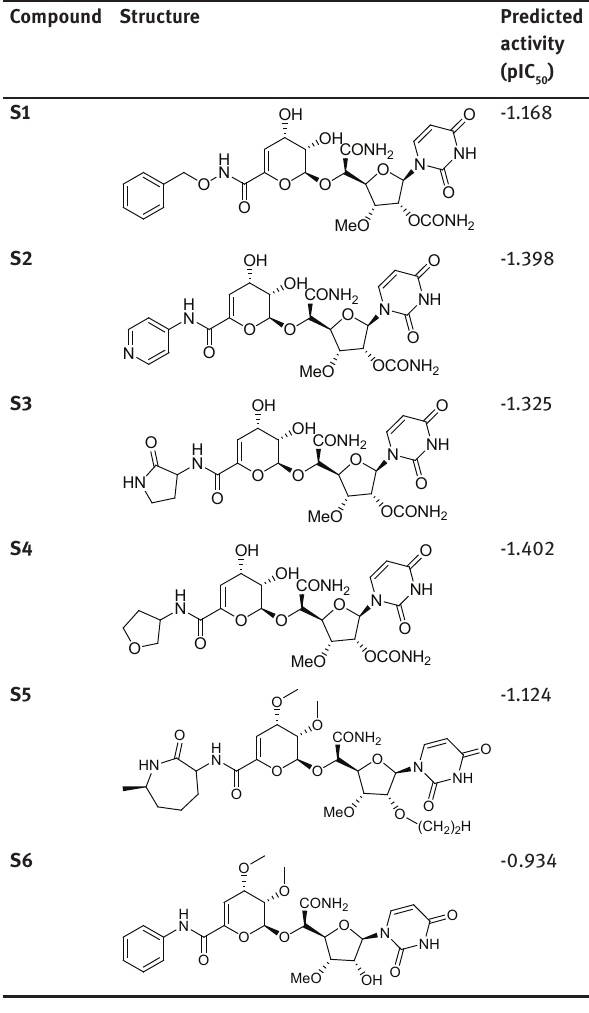
Table 2: New molecules designed based on the MFA contour. Compound